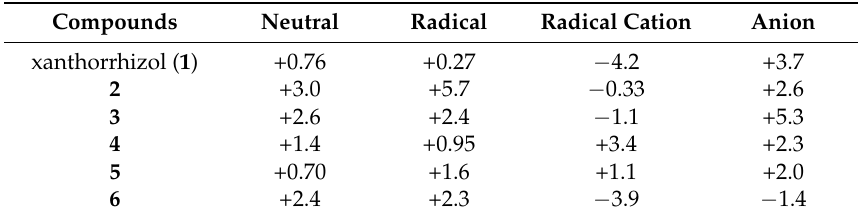
Table 1. Enthalpies of the close conformation minus the far conformation (kcal/mol). Compounds Neutral Radical Radical Cation Anion xanthorrhizol ( 1 ) +0.76 +0.27 +3.0